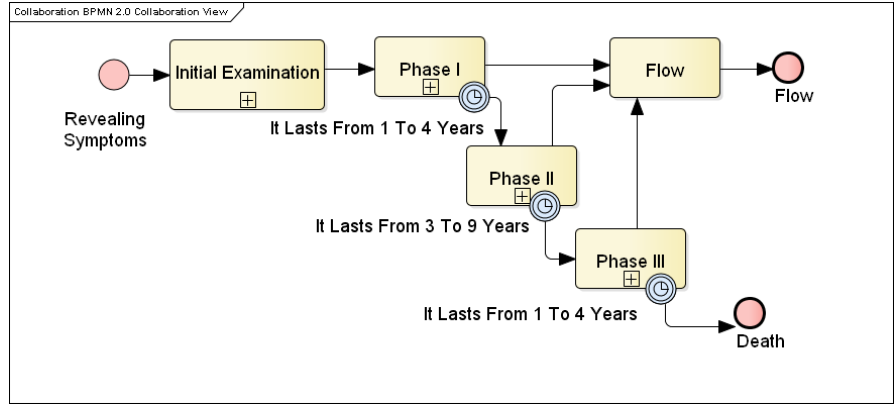
Figure 3. Main layer of the BPMN